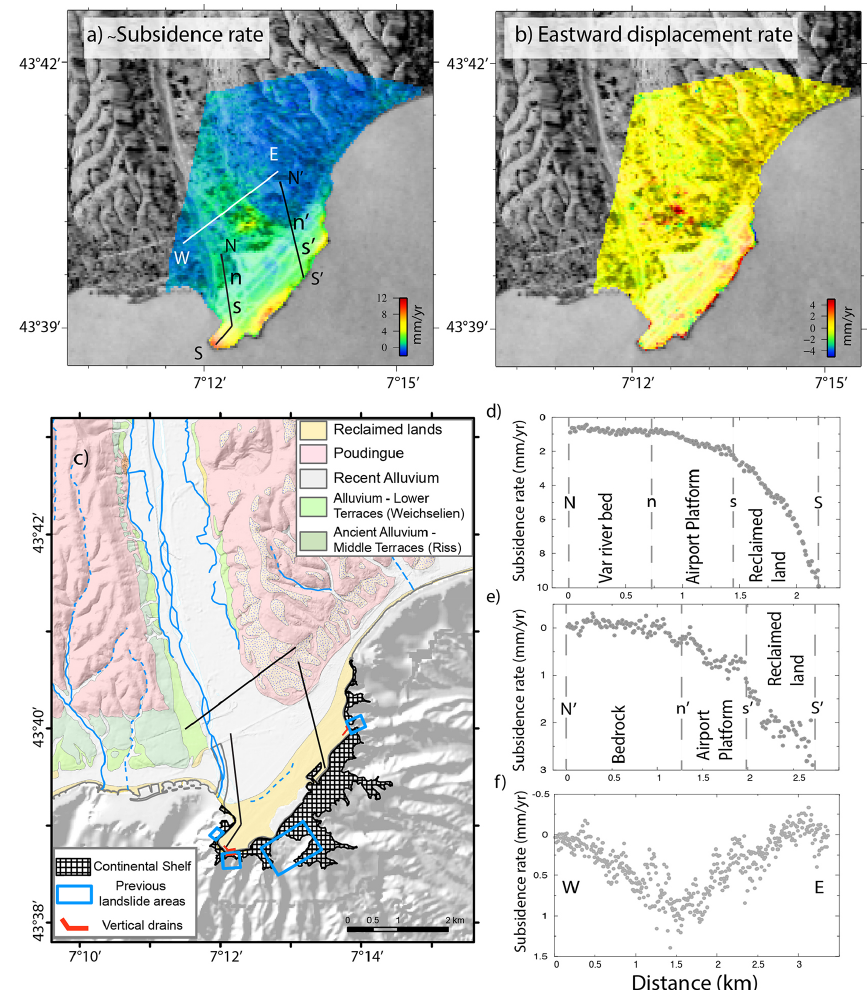
Figure 4. Near vertical component (a) and east component (b) of the ground displacement rate (in mmyr − 1 ) obtained by combining ascend- ing and descending track measurements. (c) Geological map extracted from “BRGM 50k standardized”. The topography is from “GO_06 juin 2009” and bathymetry results from compilation of marine campaign data. Observed subsidence rates along N–S (d, e) and E-W (f) profiles are shown (profile locations in Fig. 4a and c). InSAR data (gray dots) are comprised within a 2km wide box around the profile